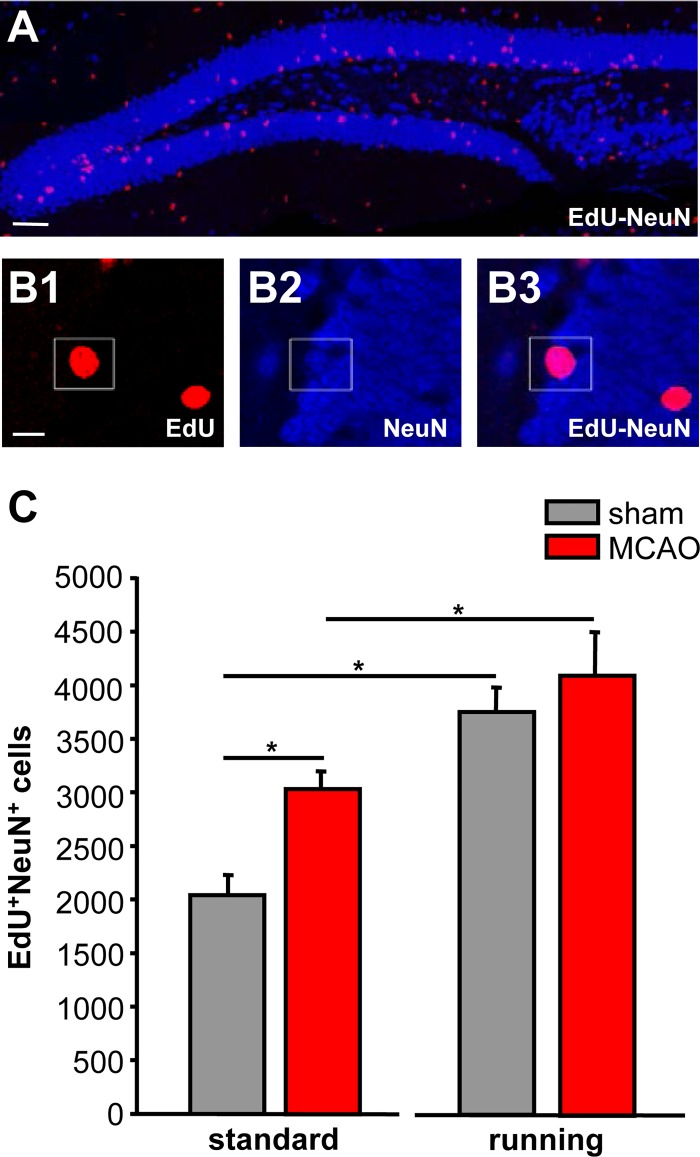
Stroke stimulates neurogenesis in adult dentate gyrus.A, Representative confocal image of dentate gyrus with newly generated neurons (red). B, Higher magnification of new neurons show colabeling of proliferation marker EdU (red) and mature neuronal marker NeuN (blue). C, Quantification of new neurons in animals housed under standard conditions or with free access to running wheels. Bars represent mean ± SEM. Asterisks indicate significant differences (p < 0.05). Scale bars represent 100 μm (A1), 10μm (B1).